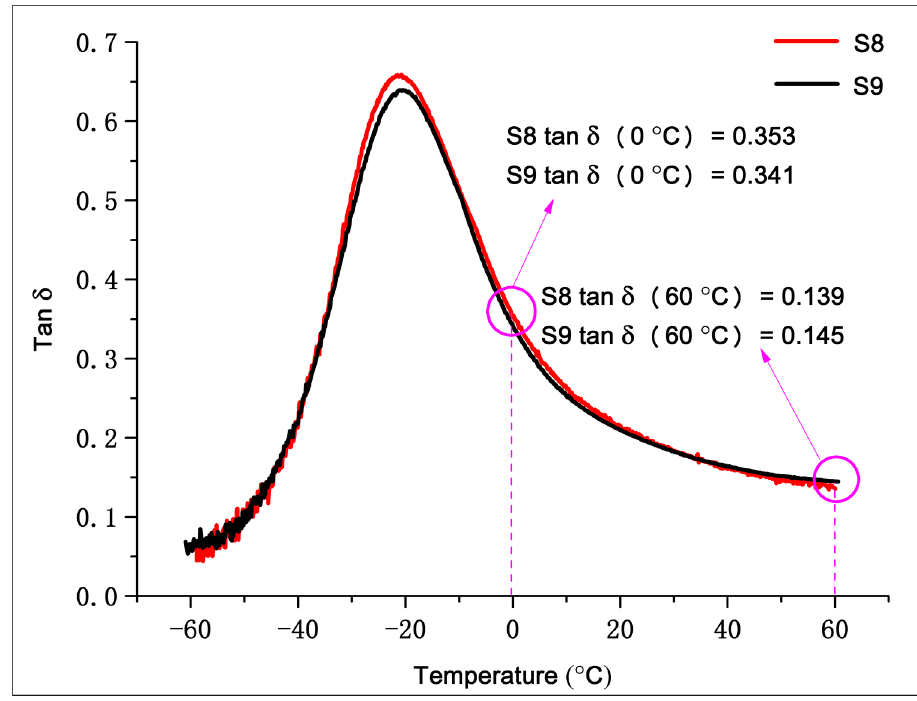
Figure 12. Results of dynamic mechanical property measurements.